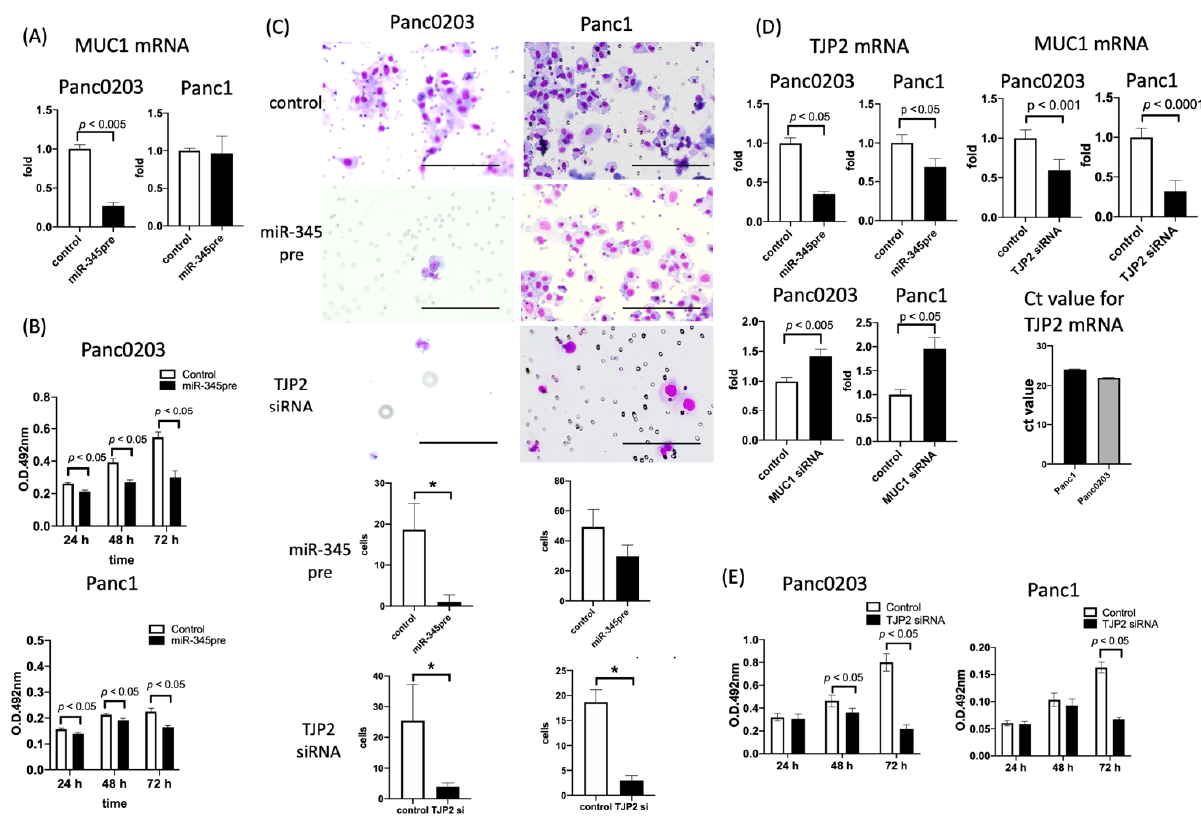
Figure 3. Changes in MUC1 and TJP2 expression, cell proliferation and invasion under miR-345pre or TJP2 or MUCI siRNA transfection. ( A ) Dynamics of MUC1 mRNA expression in Panc0203 and Panc1 under miR-345pre transduction. ( B ) The MTS assay under transfection with miR-345pre at 24, 48, and 72 h in Panc0203 and Panc1 cells. ( C ) Matrigel invasion assay showing the promotion of invasive capability of Panc0203 and Panc1 cells transfected with miR-345 and TJP2 siRNA. * p < 0.05. ( × 100; scale bar; 250 µ m) ( D ) ( Left ) Dynamics of TJP2 mRNA expression in Panc0203 and Panc1 under miR-345pre or MUC1 siRNA transduction. ( Right/upper ) Dynamics of MUC1 expression under TJP2 suppression. ( Right/lower ) Evaluation of Ct value of TJP2 mRNA by quantitative RT-PCR method. ( E ) The MTS assay under transfection with TJP2 siRNA at 24, 48, and 72 h in Panc0203 and Panc1